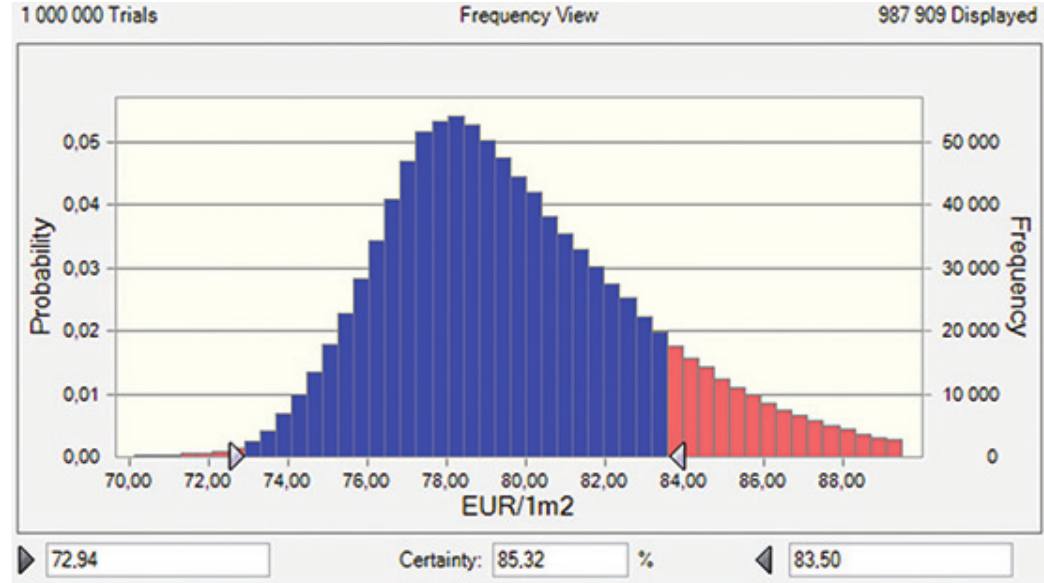
Figure 5. the interval of property value as a solution to the strategic model in the background of the simulation histogram